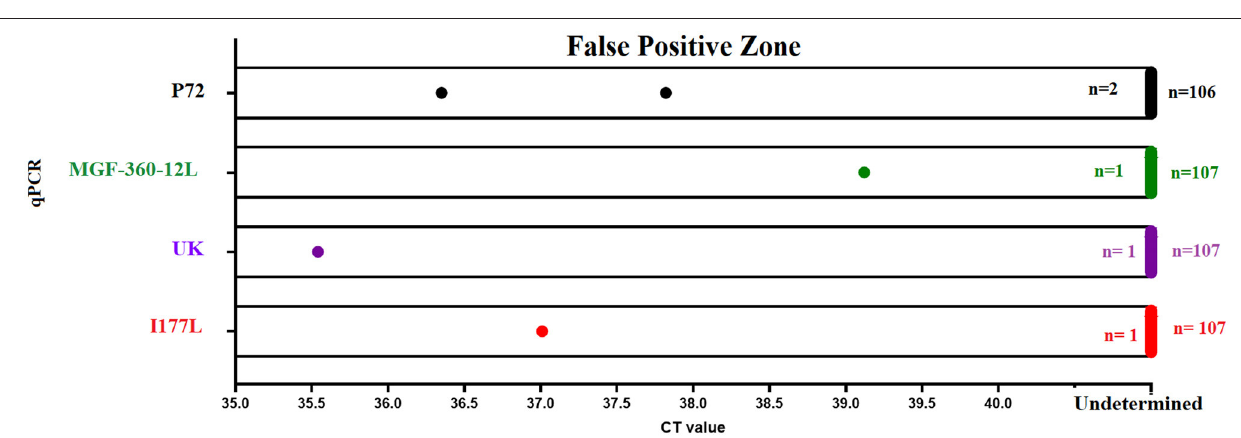
Frontiers in Veterinary Science | www.frontiersin.org